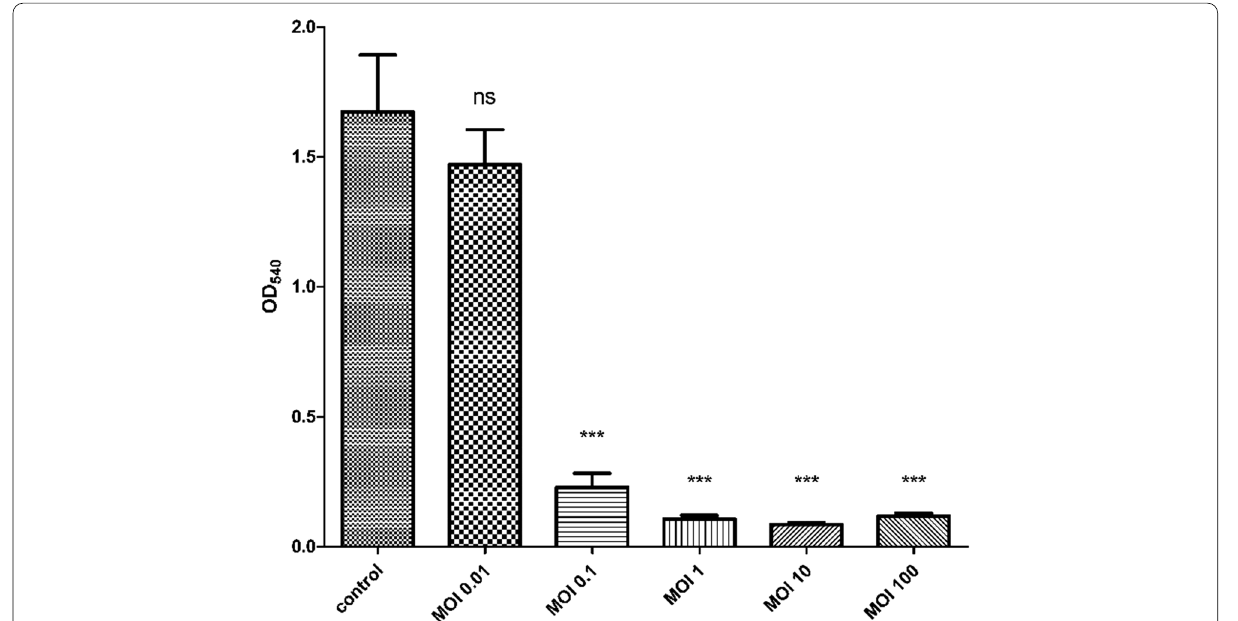
Fig. 5 The impact of different MOIs on biofilms clearance. ns stands for no significance, * P < 0.05, ** P < 0.01, and *** P <